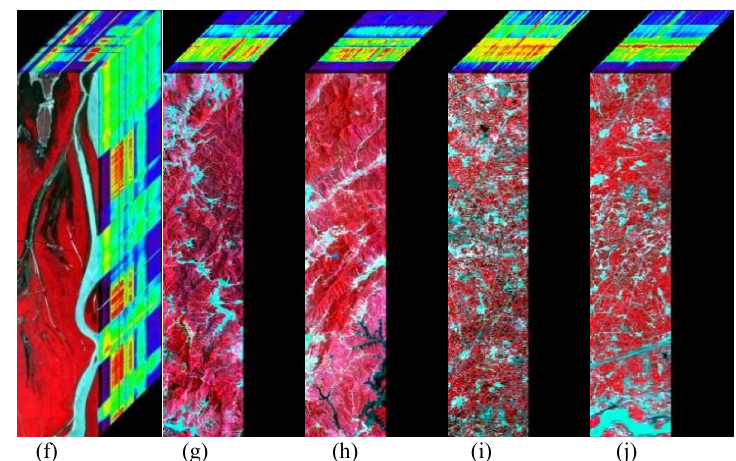
Figure 3 False color composite image of a reconstructed hyper-spectral cube: composite bands 43 (854 nm), 24 (659 nm), and 15 (569